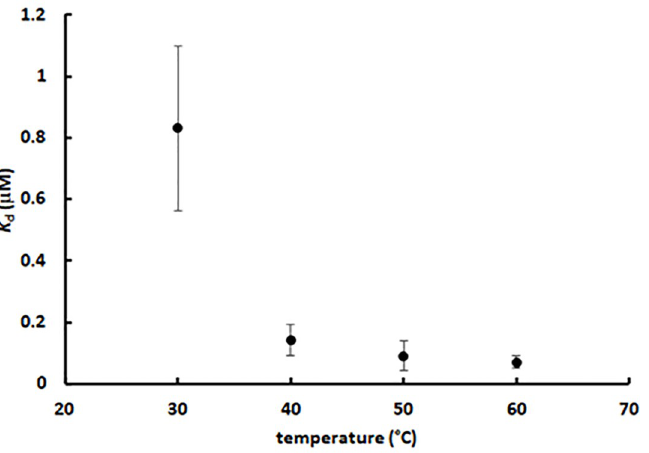
Fig 5. Determination of the dissociation constant of the HisF-HisH heterodimer at different temperatures using ITC.